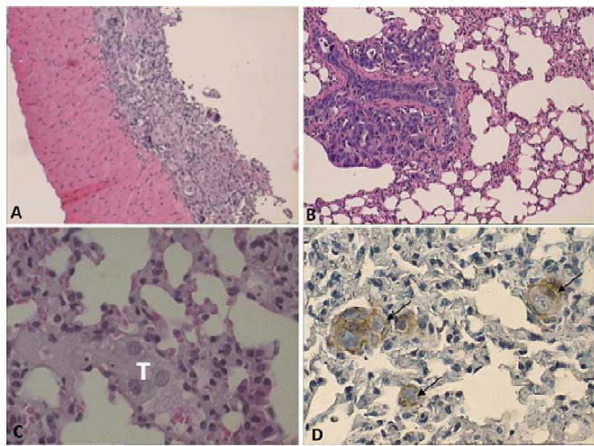
Figure 4. Spontaneous metastasis of tumor xenograft into the lung. H&E staining (100 6 magnification) reveals the presence of tumor in the diaphragm (A), and in the lung 100 6 magnification (B) and 400 6 magnification (C). The immunohistochemical staining of the tumor in the lung for HLA Class I (D) establishes that these tumors are of human origin. The sections were made from the tissues of a mouse 16 weeks after the i.p. injection of a suspension of tumor=derived cell aggregates.